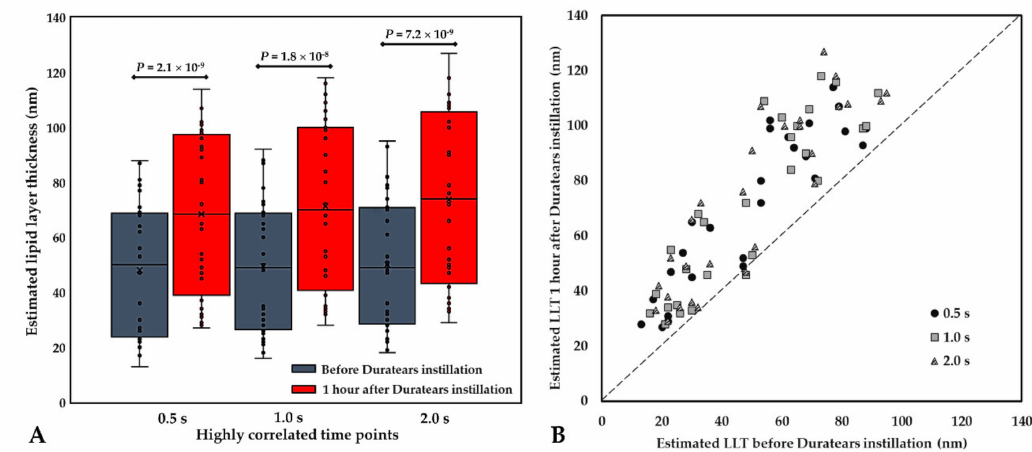
Figure 8. Using the non-segmentation images to assess the estimated lipid layer thickness before and 1 h after Duratears instillation at the highly correlated time points. ( A ) Comparison of the estimated LLT between pre- and 1-h post-ointment instillation at 0.5 s, 1.0 s, and 2.0 s in the opening phase of the blink cycle; ( B ) The change of the estimated LLT after ointment instillation for each patient at 0.5 s, 1.0 s, and 2.0 s in the opening phase of the blink cycle. Total number of subjects was 28 ( N =